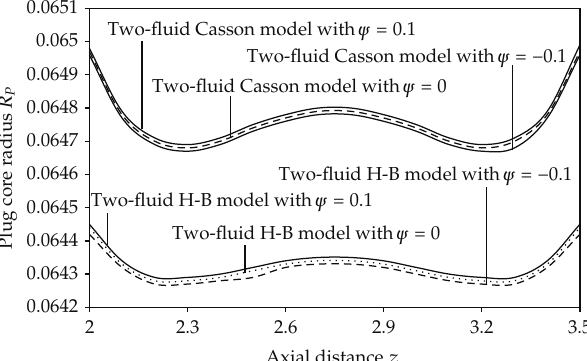
Figure 2: Variation of plug core radius with axial distance for two-fluid H-B and Casson models and di ff erent angle of tapering with b (cid:7) 0 . 1 , t (cid:7) 60 ◦ , δ P (cid:7) θ (cid:7) 0 . 1 , e (cid:7) 0 . 5 , B (cid:7) 1 , ω (cid:7) 1 , φ (cid:7) α H (cid:7) α C (cid:7) 0 . 2, and β (cid:7) n (cid:7) 0 .